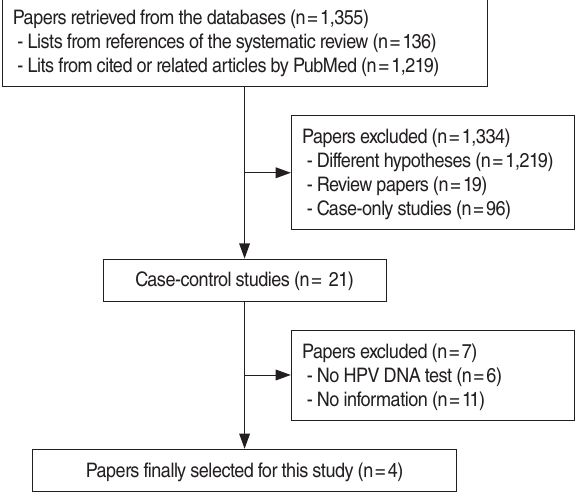
Figure 1. Flow chart of article selection. HPV, human papillomavi- rus; DNA, deoxynucleic